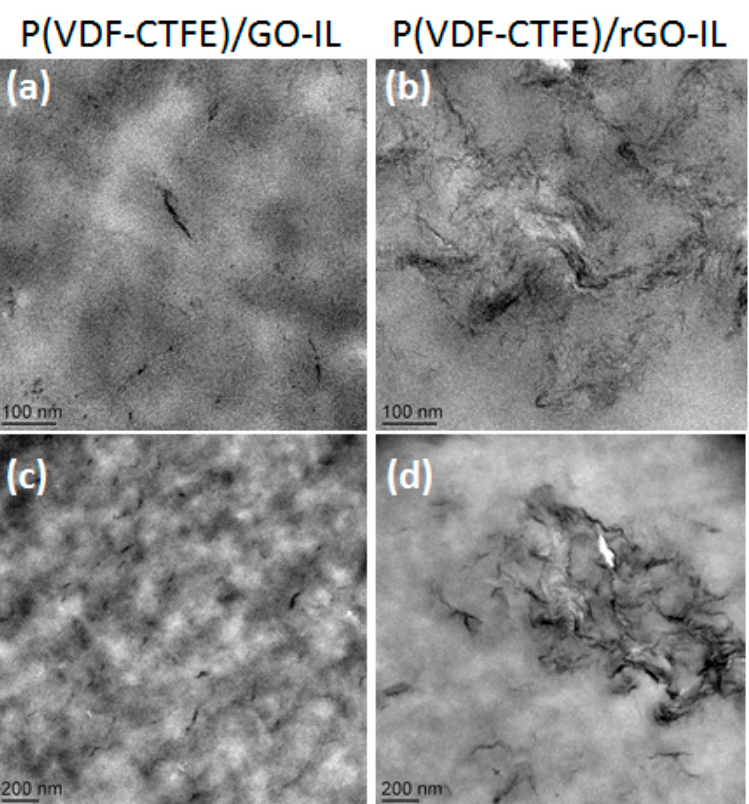
Figure 10. TEM images of poly(vinylidene fluoride-co-chlorotrifluoroethylene) (P(VDF-CTFE))/GO-IL ( a , c ) and P(VDF-CTFE)/rGO-IL ( b , d ) with 2.70 wt% of fillers.